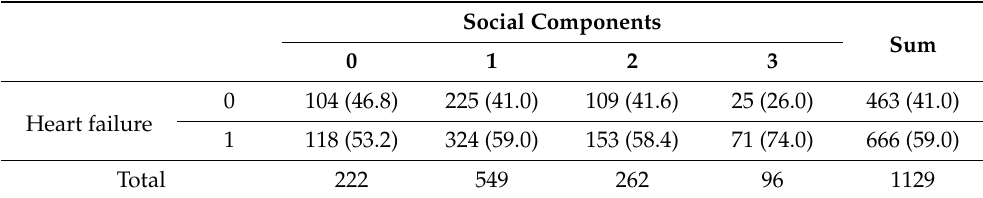
Table 6. Distribution of subjects by aggregate social component index value and heart failure occurrence. Numbers in parentheses denote column-wise